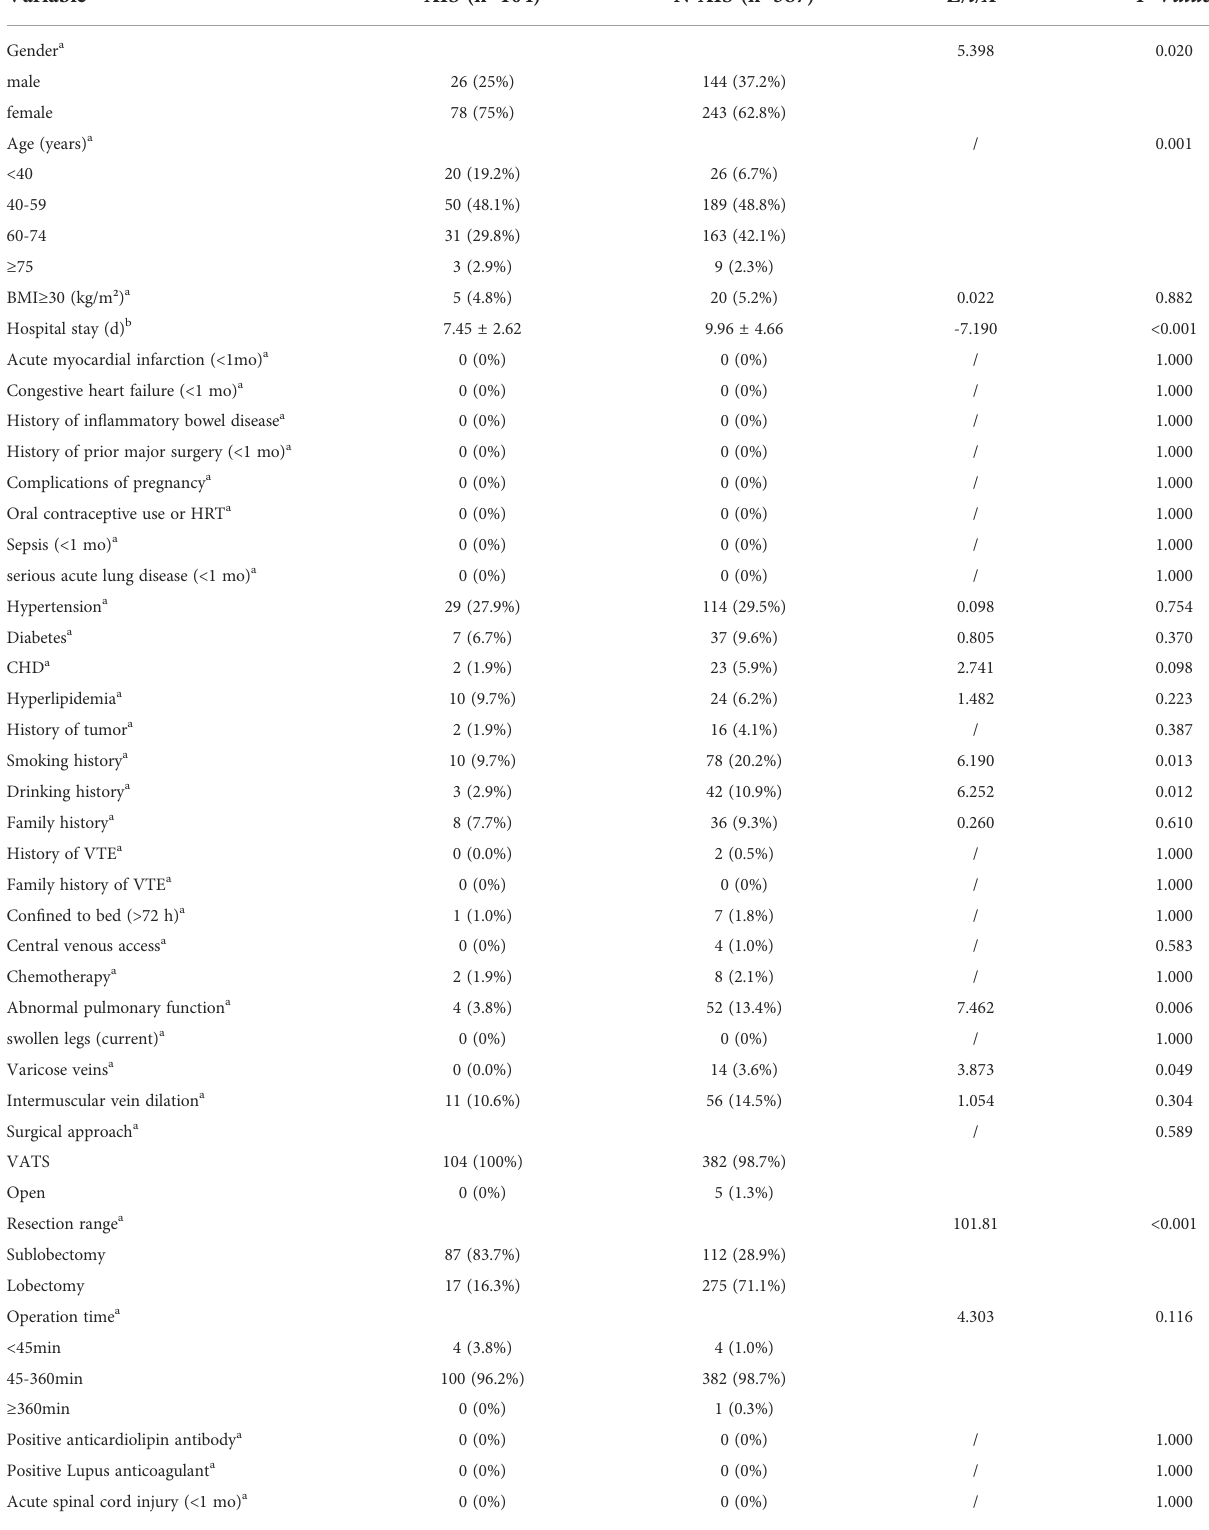
TABLE 1 Comparison of baseline data between AIS group and AD group before